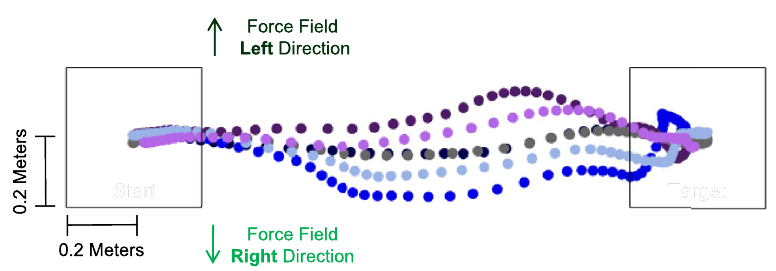
Figure 1. Experiment overview ( A ) Experimental setup, ( B ) Applied force field, and ( C ) Results: representative participant ( A ) Schematic top view of a participant shown performing the goal-directed walking task, walking from the start to the end target. The cable robot consisted of a pair of actuated cables (dashed black lines), routed through a trolley system (black circles), and attached bilaterally (grey circles) on the medial aspect of a snug pelvic harness worn by the participant. Force on each cable was controlled by a series-elastic linear motor (grey boxes). F y ( dark grey vector) represents force applied to the COM and v x (light grey vector) represents forward walking velocity . ( B ) Representation of the force applied to the participant’s COM during a force field trial. Force applied (dark grey trace) is proportional in magnitude to forward walking velocity (light grey trace) with a gain of 80 N/(m/s) and was applied in a randomized order towards either towards the participant’s right or left side each trial. ( C ) COM trajectory during select trials from analysis periods for a single representative